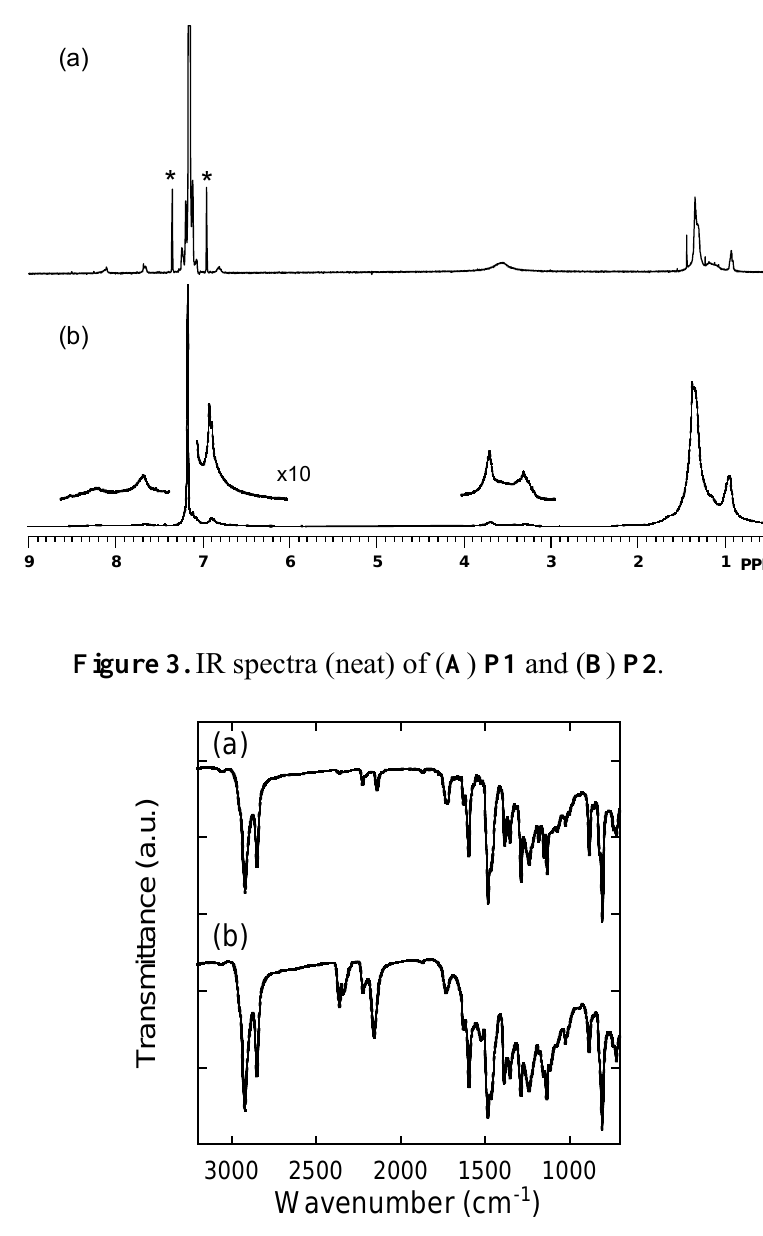
Figure 2. 1 H NMR spectra of ( A ) P1 and ( B ) P2 in CDCl bands of the solvent peak are marked.